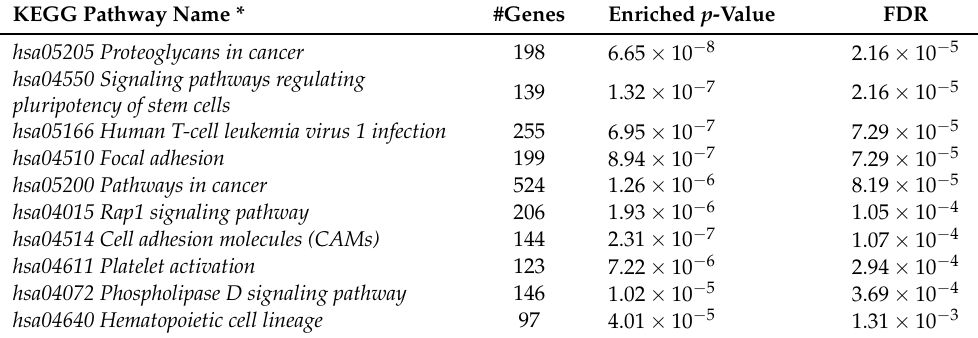
Table 5. Top significant KEGG Pathways (FDR sorted).